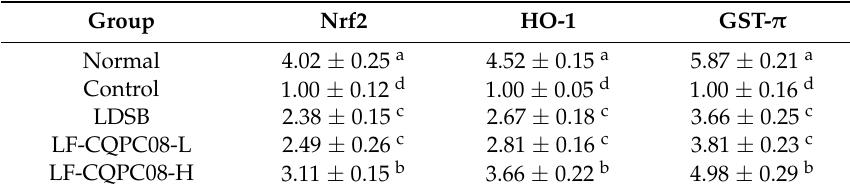
Table 8. Nrf2, HO-1, and GST- π mRNA expression in tongue tissue of mice (relative to multiple of control group).